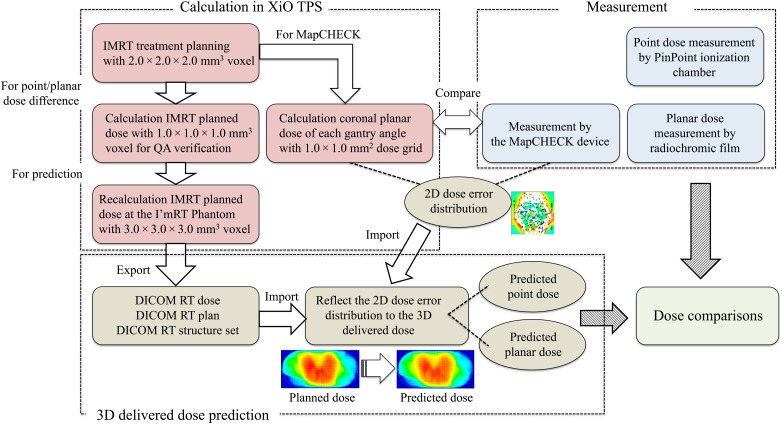
The flowchart of 3D delivered dose prediction. Four individual pieces of data are required for delivered dose prediction: DICOM RT plan, DICOM RT structure set, DICOM RT dose, and the 2D relative dose error in the coronal plane. The DICOM dataset was exported from the XiO TPS. The 2D relative dose error was created from dose comparisons between the measured and the calculated dose using in-house software.